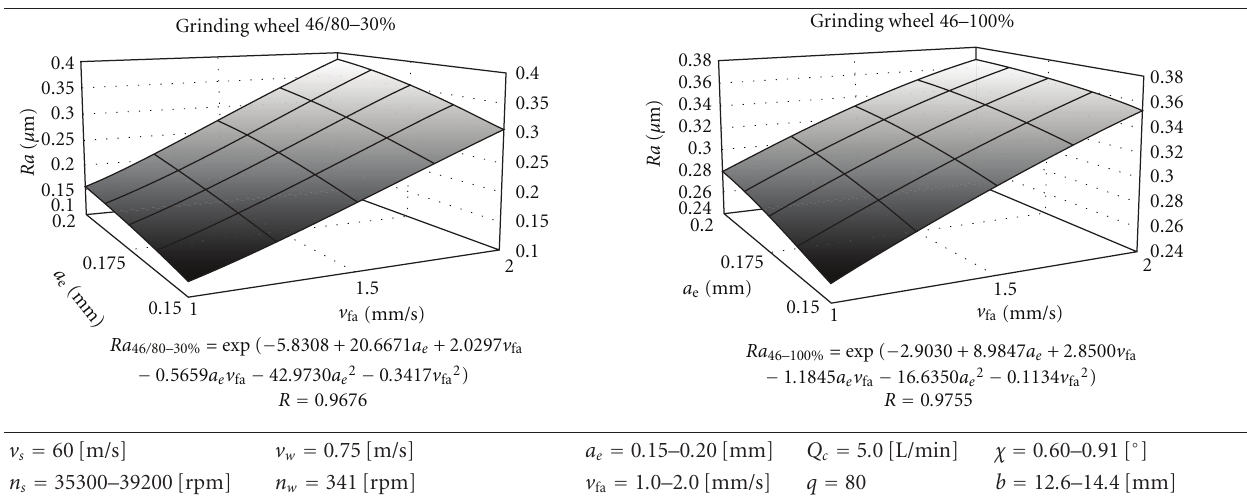
Table 1: Breakdown of mathematical models describing the changes in the surface roughness of a workpiece Ra as a function of the working engagement a e and axial table feed speed v fa [22].